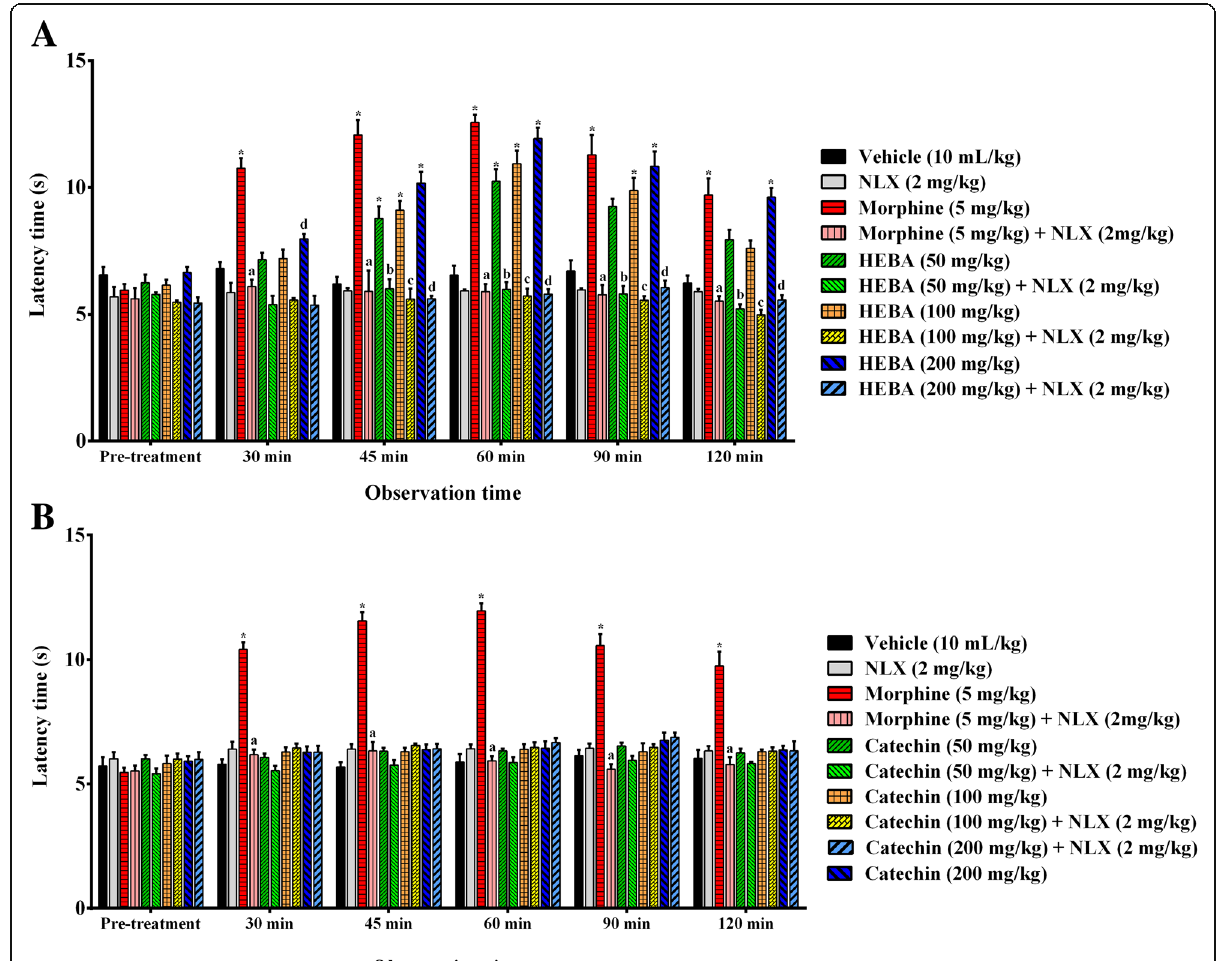
Fig. 2 Effect of morphine, HEBA, (+)-catechin and naloxone treatments on latent time in hot plate test. Panel a shows the effect of HEBA and naloxone pre-treatment on latency. Panel b shows the effect of (+)-catechin and naloxone pre-treatment on latent time. Data are presented as mean ± SEM ( n = 5). * represents p < 0.001, compared to control group mice. a, b, c and d represent p < 0.001, compared to 50, 100 and 200 mg/Kg b.w. dose treatment group respectively. HEBA = hydro-methanolic extract of the bark of A. lacucha . NLX =